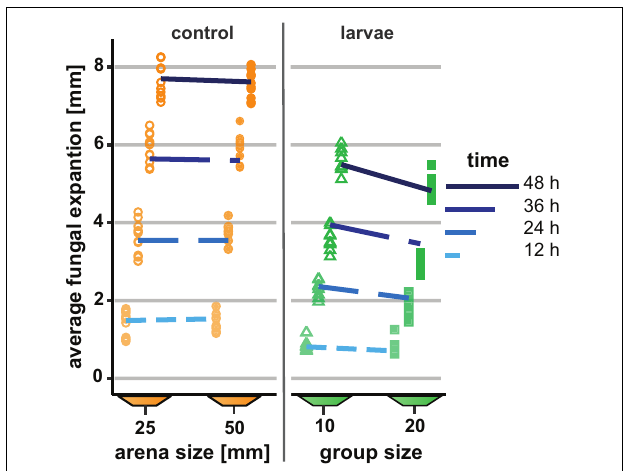
FIGURE 3 | Effect of Drosophila melanogaster larvae at two different group sizes on the expansion of the insecticidal filamentous fungus Aspergillus nidulans . Expansion of the fungus across the substrate in small (open symbols) and large (filled symbols) arenas without larvae (“control,” left-hand side) and as affected by the presence of Drosophila larvae with 10 or 20 larvae (“larvae,” right-hand side). Dashed lines depict the fitted model estimates for the four time points. For the insect treatment, the density of larvae was 0.4/mm fungal growth front and 1.6/cm 2 arena in both the small and the large arenas. The GEE was applied separately for arenas with and without larvae, while larva-free fungal colonies showed no significant difference between arena sizes; confronted colonies were more suppressed over time by larger larval groups ( Table 1 ).